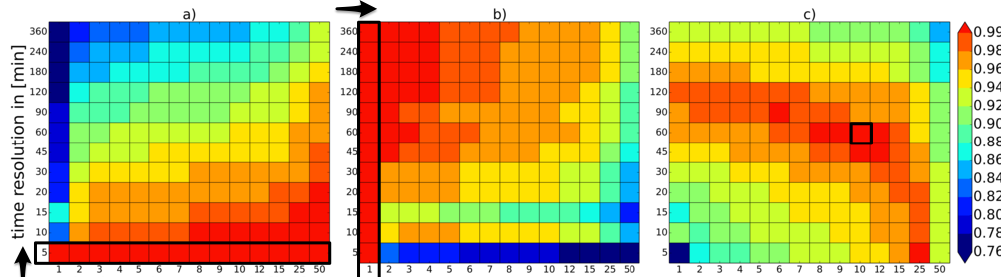
Figure 10. PDF overlap for convective precipitation intensity. All of Germany for the years 2007–2008, aggregated to different horizontal (horizontal axis) and temporal (vertical axis) resolutions. (a) PDF overlap of each horizontal resolution between every temporal resolution and the 5min data. (b) PDF overlap of each temporal resolution between every horizontal resolution and the 1km data. (c) PDF overlap of each horizontal and temporal resolution compared to the 10km, 60min